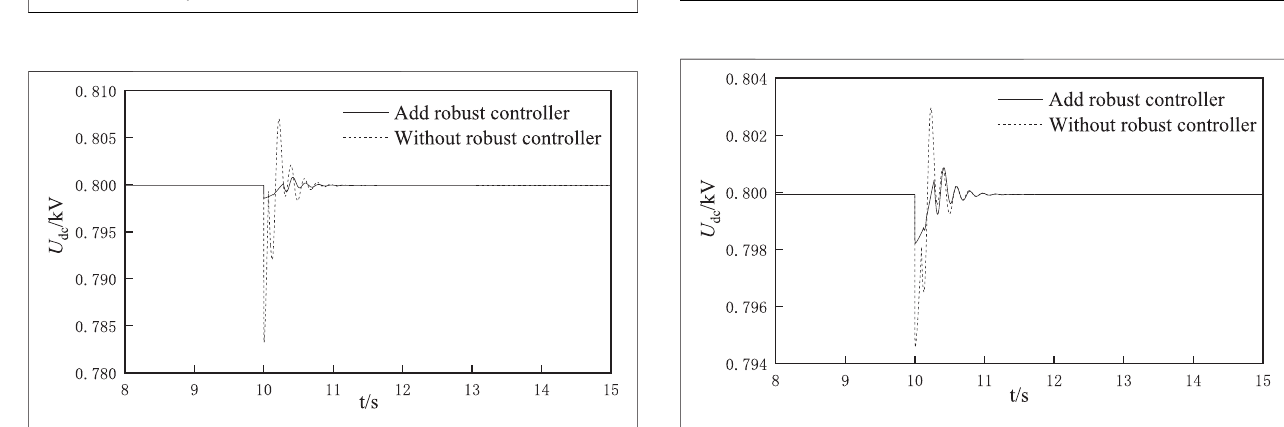
FIGURE 9 | DC bus voltage waveform when two electric vehicle is connected to the system.